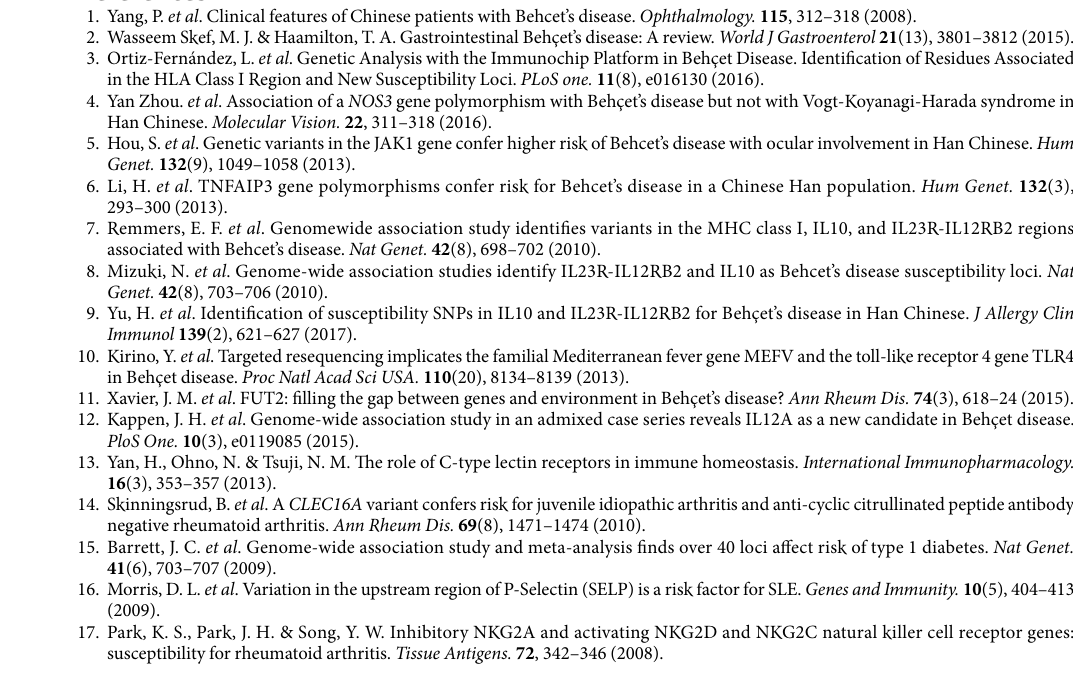
7 Scientific RepoRts | 7: 5348 | DOI:10.1038/s41598-017-05877-x